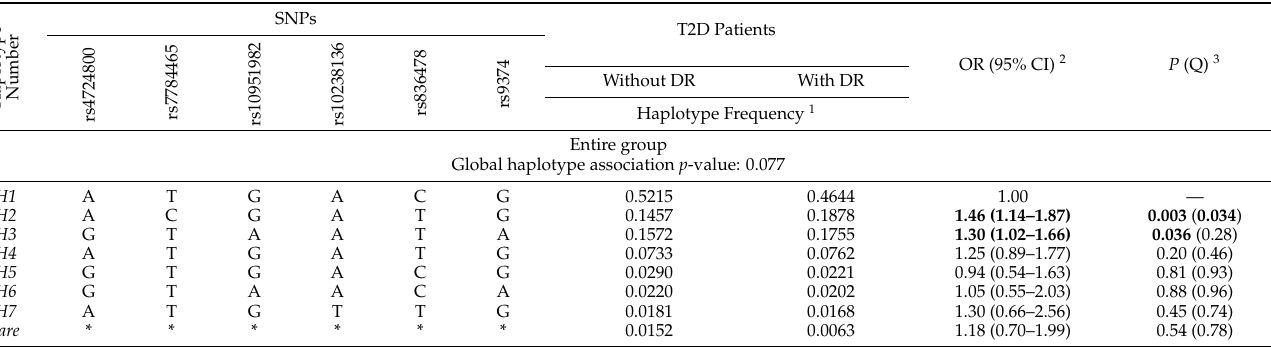
Table 3. Estimated common haplotype frequencies of RAC1 gene in T2D patients with and without diabetic